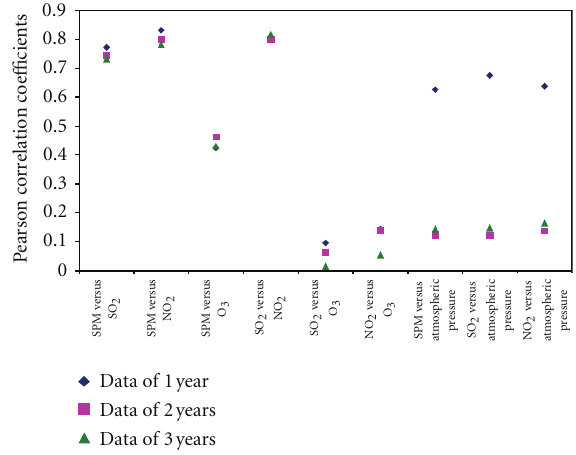
Figure 2: Pearson correlation coe ffi cients between the various climatic and pollutant parameters.